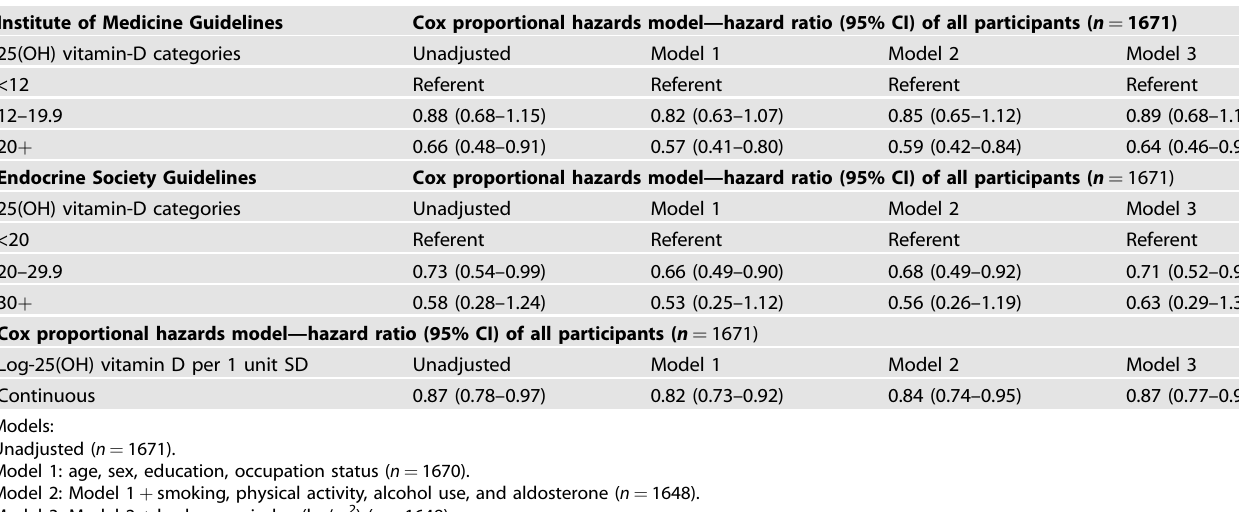
Table 3. The association of total 25(OH) vitamin D with incident diabetes among participants with detectable vitamin D2 and D3. Institute of Medicine Guidelines